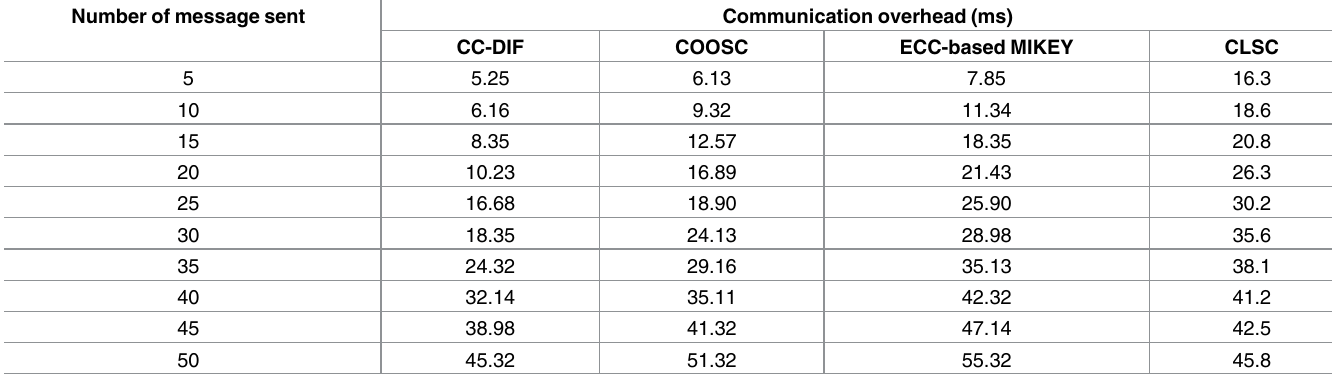
Table 4. Tabulation for communication overhead.